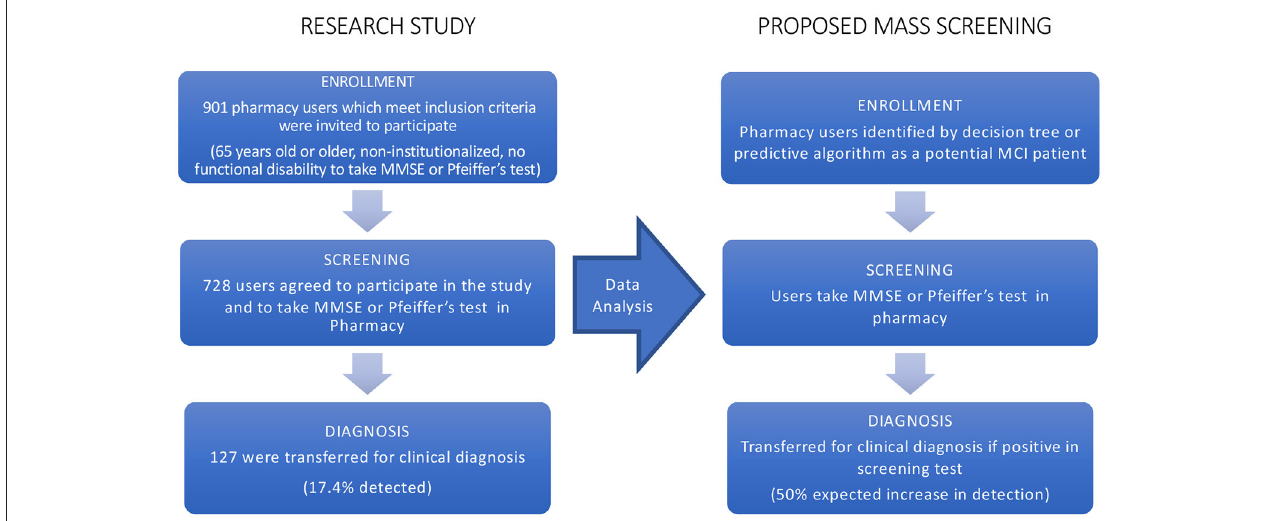
FIGURE 1 | Flowchart of the research study. The flow on the left represents the research study whose data were applied machine learning algorithms. As a result of these techniques, a mass enrollment is proposed for early detection of MCI and the flowchart of the procedure is displayed on the